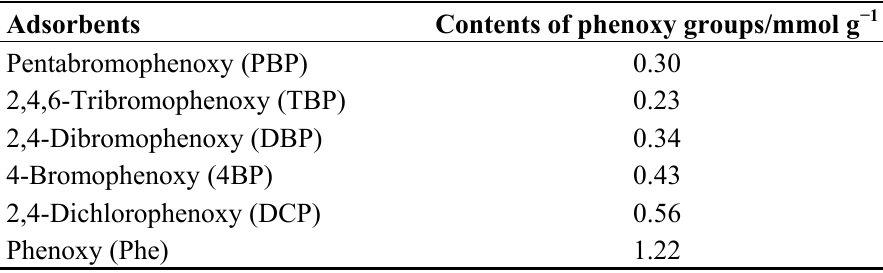
Table 1. Contents of functional group in the prepared